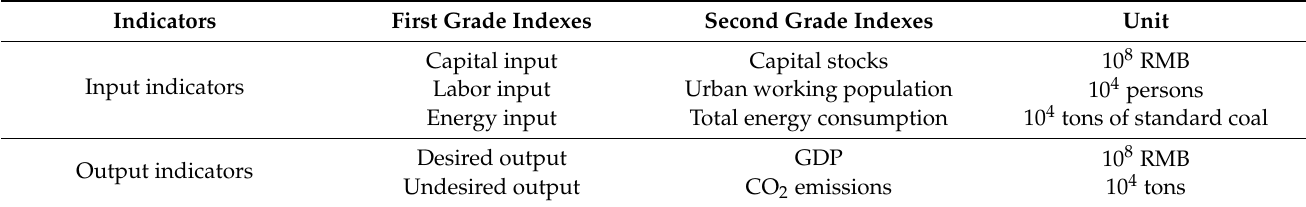
Table 5. CEE input-output indicator